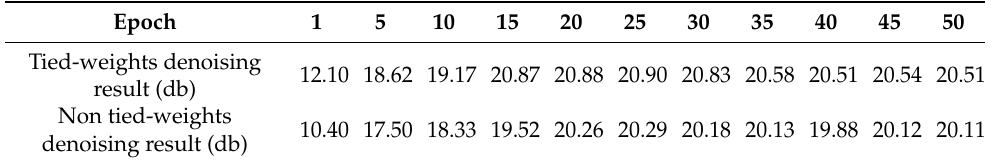
Table 4. Denoising results with respect to the epochs of tied weights and non-tied weights.